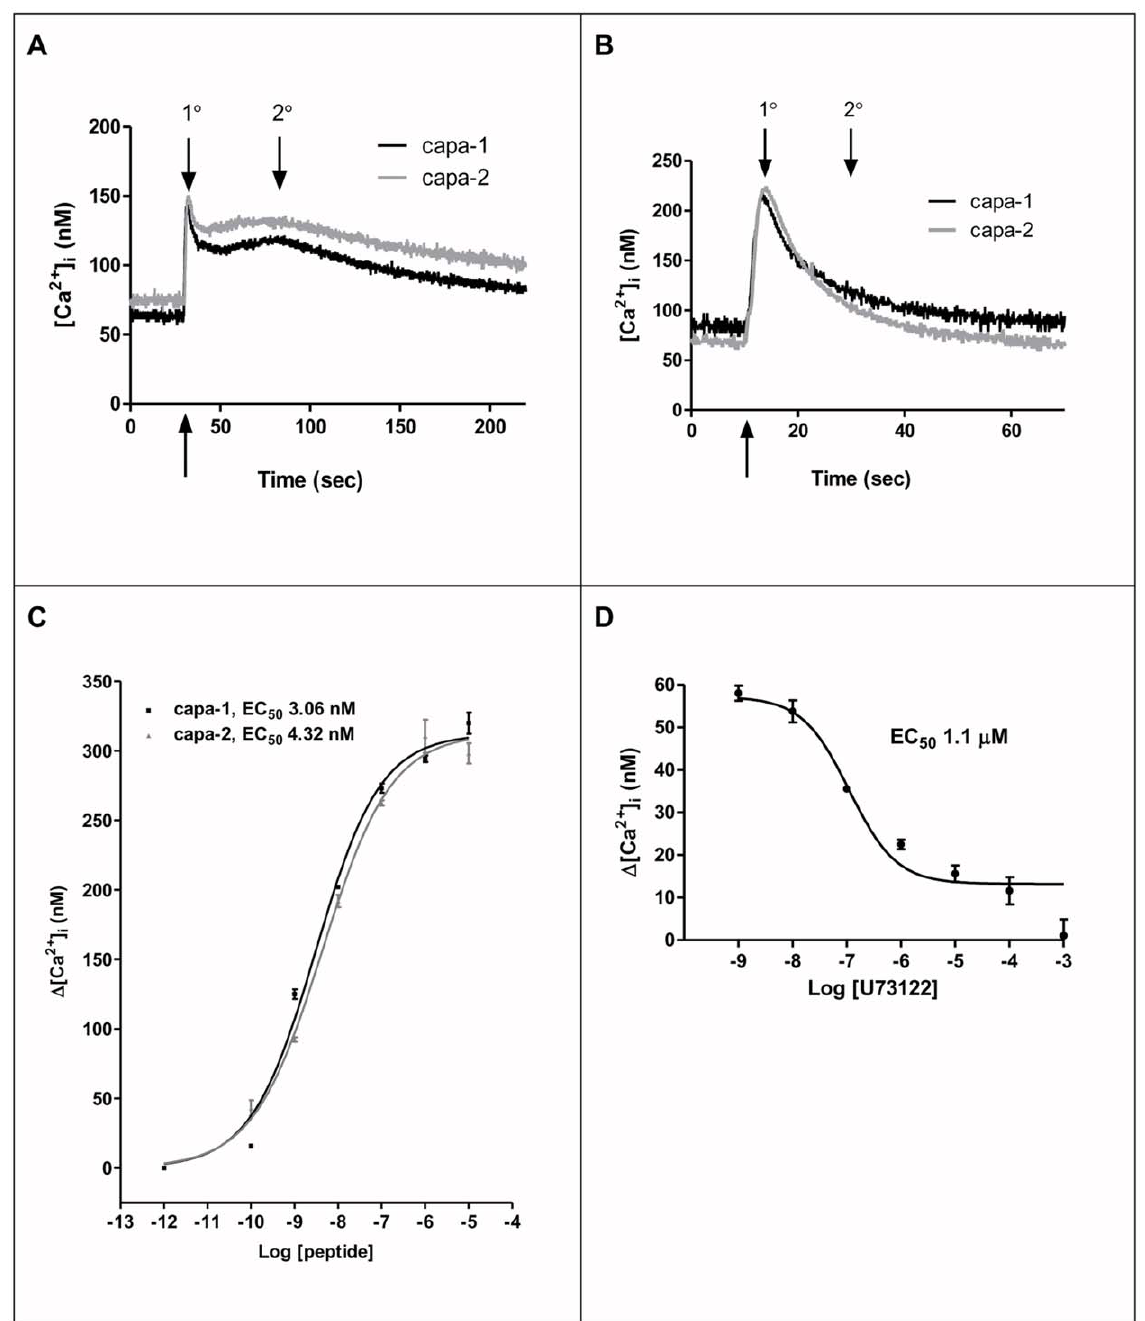
Figure 1. [Ca 2 + ] i signatures in response to capa-1 and capa-2 in capaR- and apoaequorin-transfected S2 cells. ( A ) [Ca 2 + ] i increases stimulated by 10 2 7 M capa-1 (black) and capa-2 (grey). The traces shown are typical data from single experiments. Data are expressed as [Ca 2 + ] i (nM) against time (s); each data point corresponds to 0.1 s; agonist injection indicated by an arrow. ( B ) Real-time measurement of the [Ca 2 + ] i response to the capa peptides under Ca 2 + -free conditions. Data are expressed as [Ca 2 + ] i (nM) against time (s); each data point corresponds to 0.1 s. The graphs display [Ca 2 + ] i increases in capaR and apoaequorin expressing S2 cells. Traces shown are typical data from single experiments in response to 10 2 7 M capa-1 (black) or capa-2 (grey) in the absence of Ca 2 + . In ( A ) and ( B ) the upward arrow indicate the time of peptide agonist injection while the downward arrows indicate the primary and secondary capa-induced calcium responses. ( C ) Dose-response curves for capa-1 and capa-2. Action of the capa peptides (capa-1 (black) or capa-2 (grey)) on S2 cells expressing capaR and apoaequorin. Values were expressed as maximal (nM) - background (nM) (mean 6 S.E.M., N =6). Where error bars are not visible they are too small to reproduce. ( D ) Concentration-response for the action of the PLC inhibitor U73122. Cells were challenged with increasing concentrations of U73122, and calcium mobilization was measured. Values were expressed as maximal (nM) - background (nM) (mean 6 S.E.M., N =3).